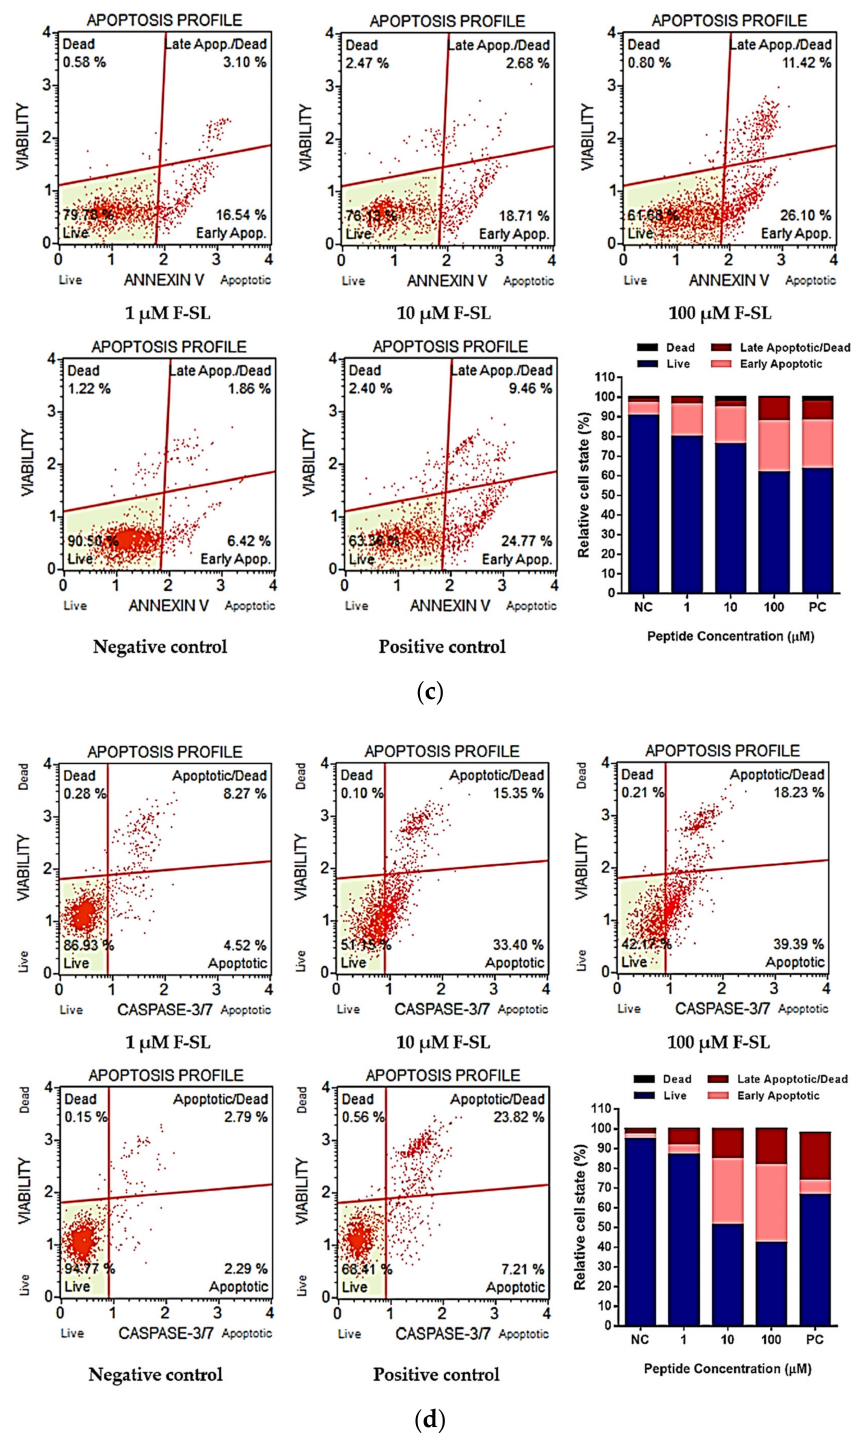
Figure 7. Assessment of apoptosis and relative state percentage in H157 and H838 cell lines induced by F-SL of di ff erent concentrations. ( a ) Representative plots from Annexin V-FITC / 7-AAD assay after 8 h incubation on H157. ( b ) Representative plots from Caspase 3 / 7 / 7-AAD assay 16 h incubation on H157. ( c ) Representative plots from Annexin V-FITC / 7-AAD assay after 8 h incubation on H838. ( d ) Representative plots from Caspase 3 / 7 / 7-AAD assay 16 h incubation on H838. The gated cells with quadrant marker divided date into live, apoptotic, apoptotic / dead and dead populations. Positive drug control groups were treated with 1 mM 5-FU and negative control groups were acquired after treated with culture